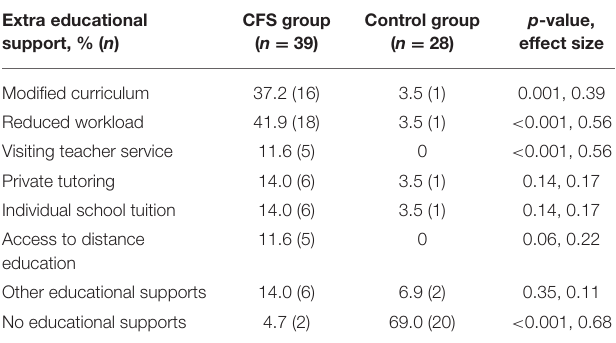
TABLE 2 | Extra educational